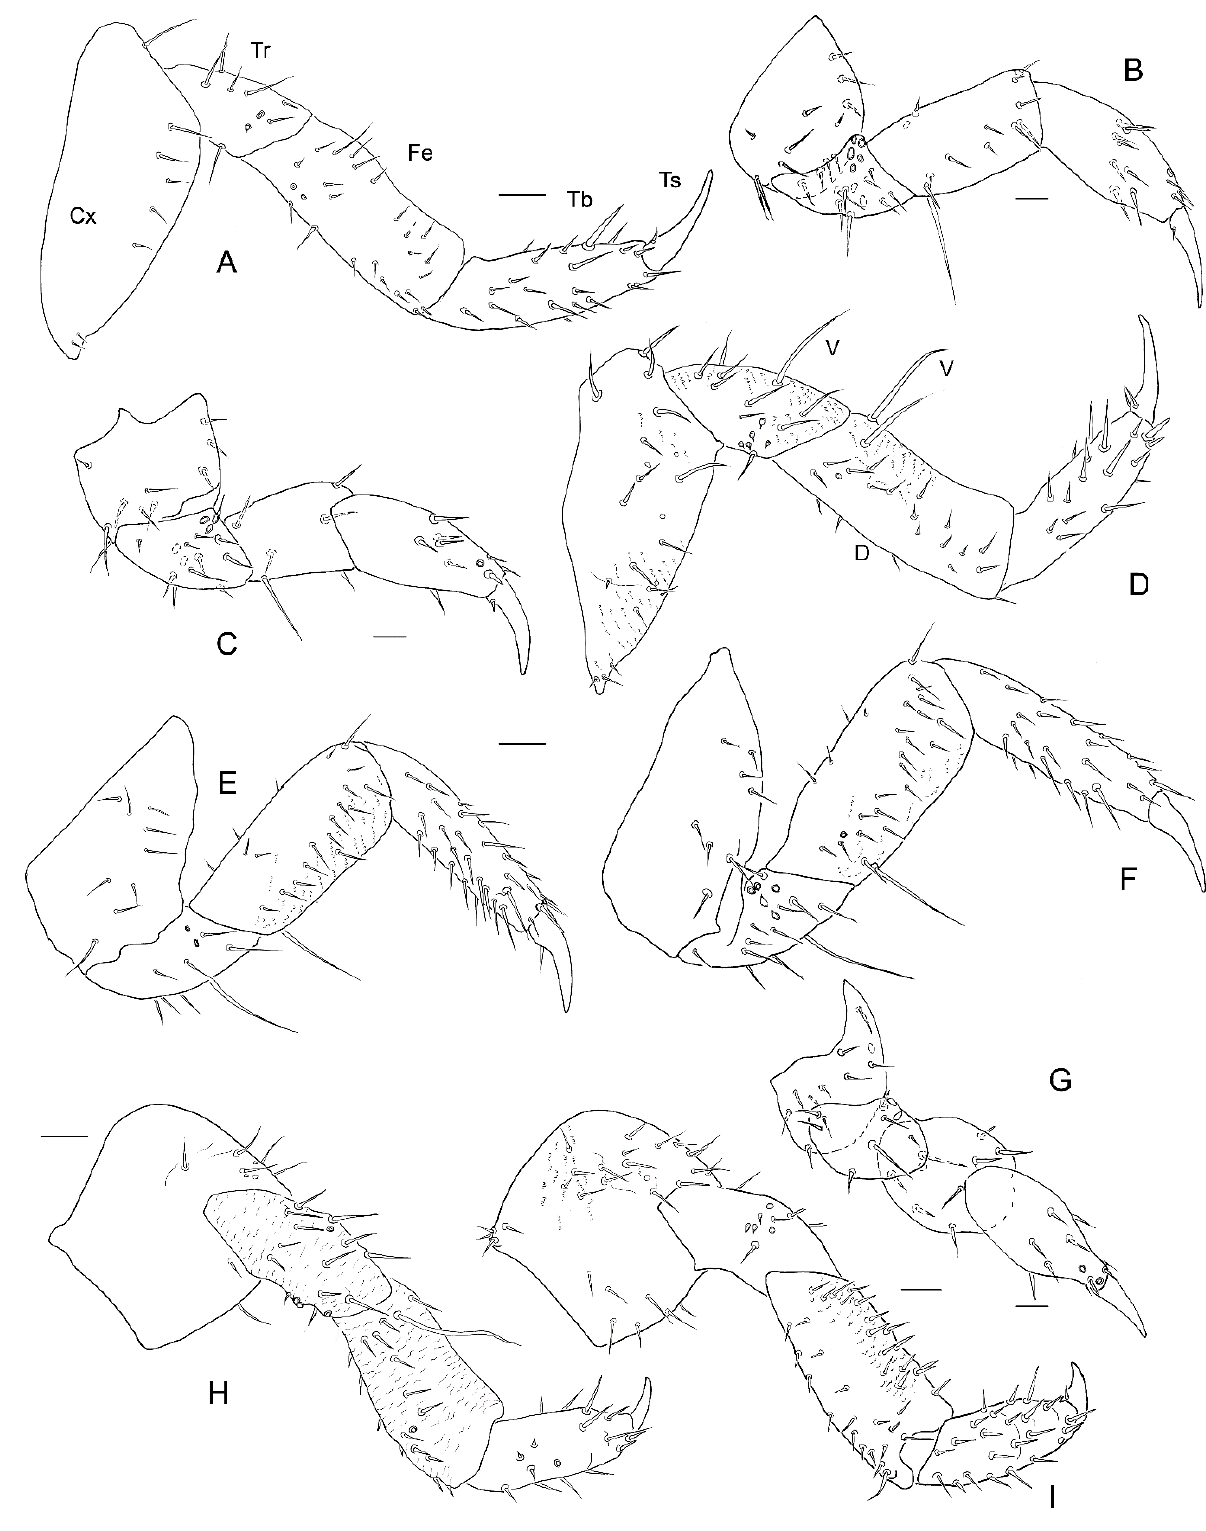
Figure 19. Leiodes cinnamomea. Details of larval morphology of legs. ( A , B , D ) Proleg. ( A ) Posterior view, instar III. ( B ) Instar II. ( D ) Anterior view, instar III. ( C , E , F ) Midleg. ( C ) Instar II. ( E ) Anterior view, instar III ( F ) Posterior view, instar III. ( G – I ) Hindleg. ( G ) Instar II. ( F ) Anterior view, instar III. ( I ) Posterior view, instar III. Abbreviations: Cx—coxa; Fe—femur; Tb—tibia; Tr—trochanter; Ts—tarsungulus. Scale bars = 0.1 mm.